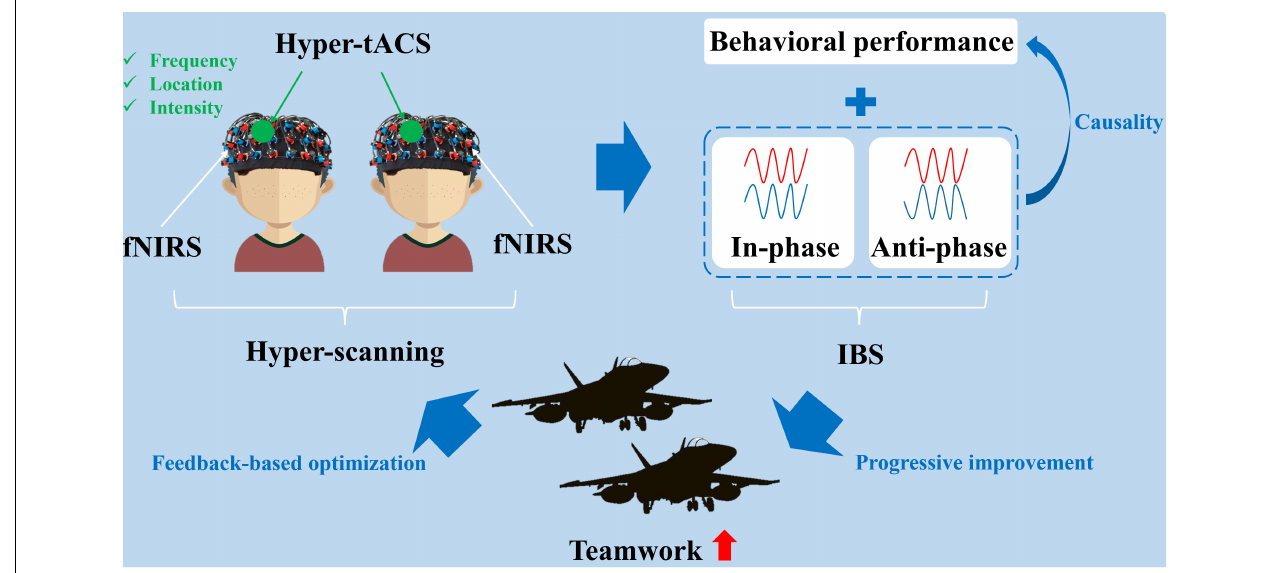
FIGURE 3 | Possible technical routes for research on military pilot teamwork